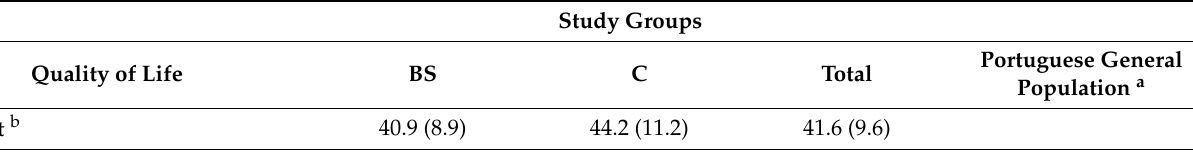
Table 2. QoL data from the EQ-5D-3L and BQL between the BS and C groups and between BS and the Portuguese general population. Study